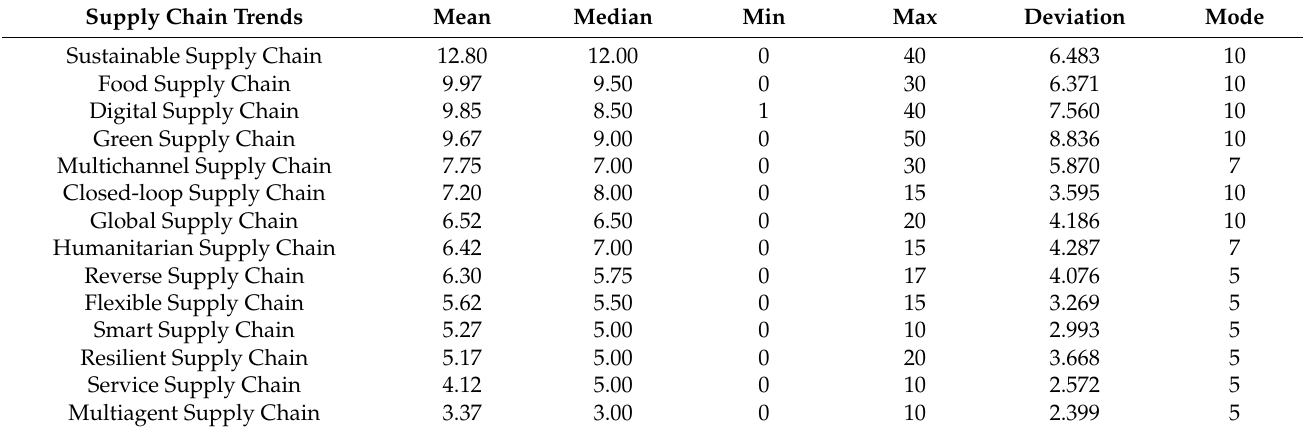
Figure 13. Ranking graph of global theoretical trends and supply chain development directions in the context of great changes in consumer behavior according to the experts’ assessments 1–30; own elaboration based on the conducted research. Table 5. Final results of opinions about global theoretical trends and supply chain development directions in the context of great changes in consumer behavior according to the experts’ assessments 1–30; own elaboration based on the conducted research.